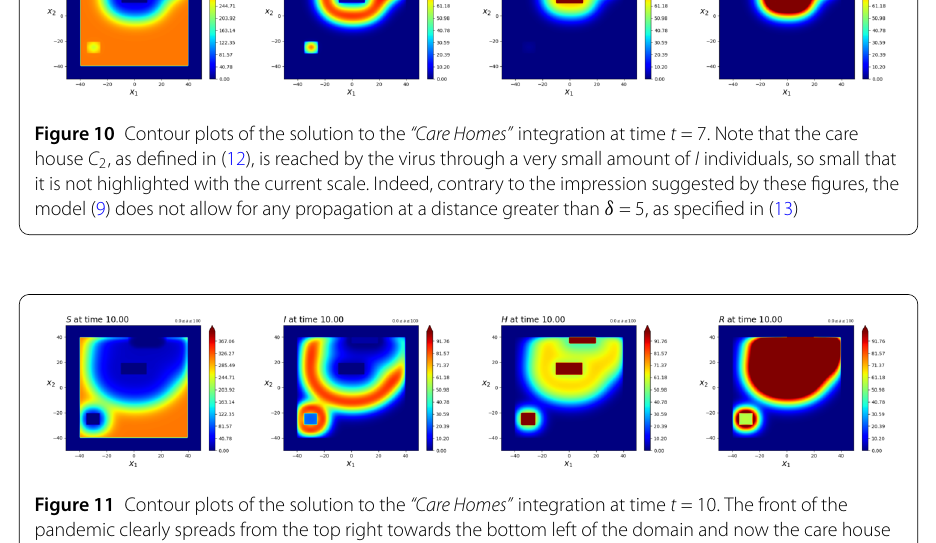
see Fig. 8. Quickly, at time t = 3, the virus reaches the first care home C 1 , see Fig. 9. As a consequence, the pandemic accelerates and, at time t = 7, also C 2 is widely infected, see Fig. 10. This further accelerates the spreading, with C 2 clearly acting as a further source of infection, see Fig. 11. At time t = 10, the two fronts of the pandemic propagation are evident: the first one due to the initial presence of infected individuals, the second one emanating from C 2 . Finally the situation at time t = 13 is plotted in Fig.